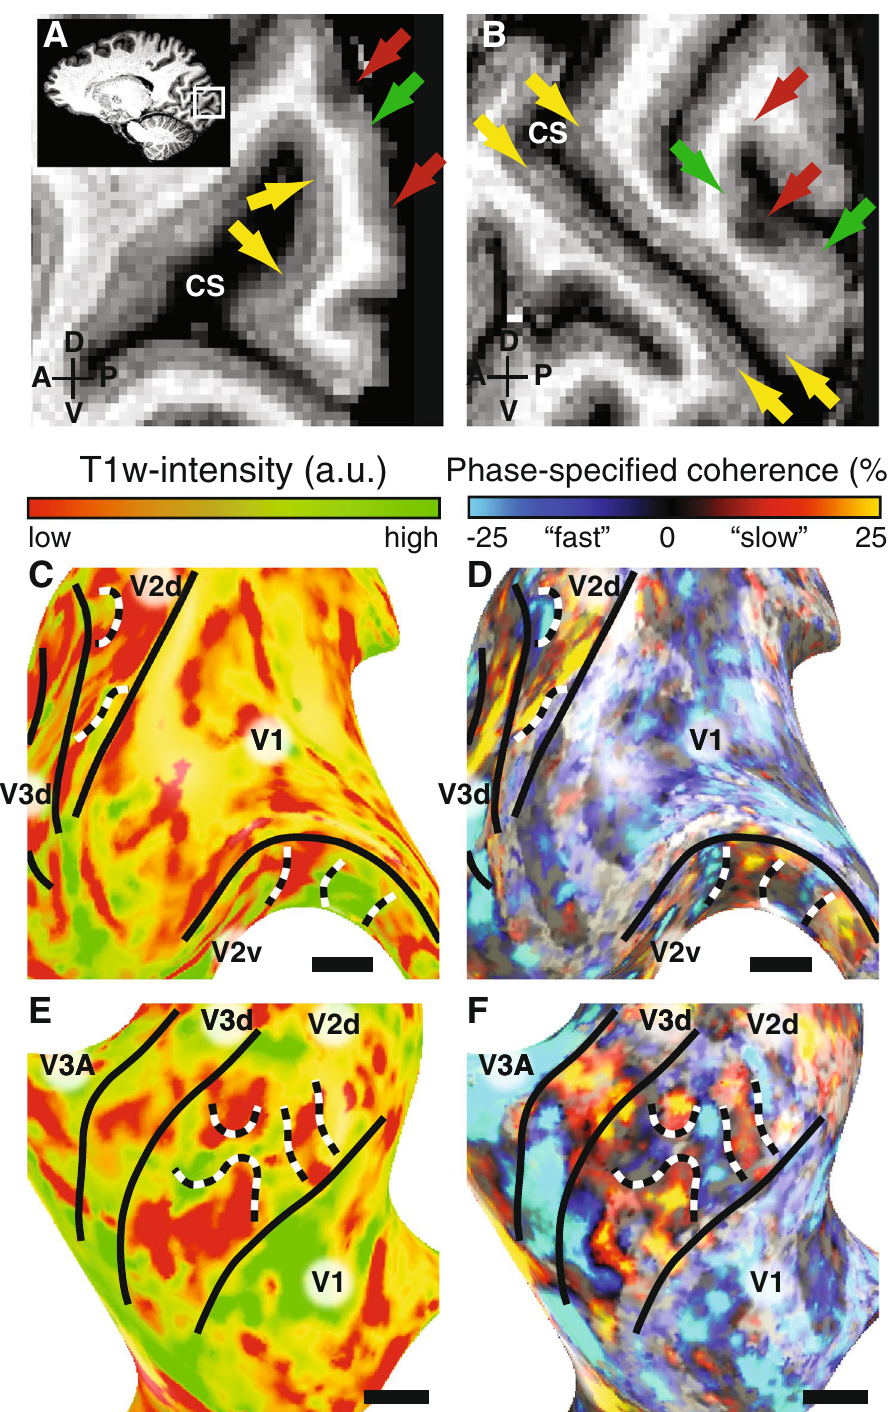
Figure 3. T1w anatomical delineation of V2 and V3 stripe-based subdivisions. High-resolution T1w data is shown in panels A (S1) and B (S2). The data reveal the stria of Gennari (yellow arrows), and stripes in V2 cortex with low and high T1w intensity, associated with less and more myelinated regions (red and green arrows, respectively). The median T1w intensities across the cortical thickness are shown on the cortical surface in panels C (S1) and E (S3). The corresponding functional responses of these subjects are shown in panels D and F (identical to Fig. 1). The black horizontal line indicates 1 cm in each panel. In line with the functional responses a patchy distribution of T1w intensity is observed along visual cortex. Black and white dashed lines mark borders within V2 that illustrate correspondence between T1w intensity changes and functional